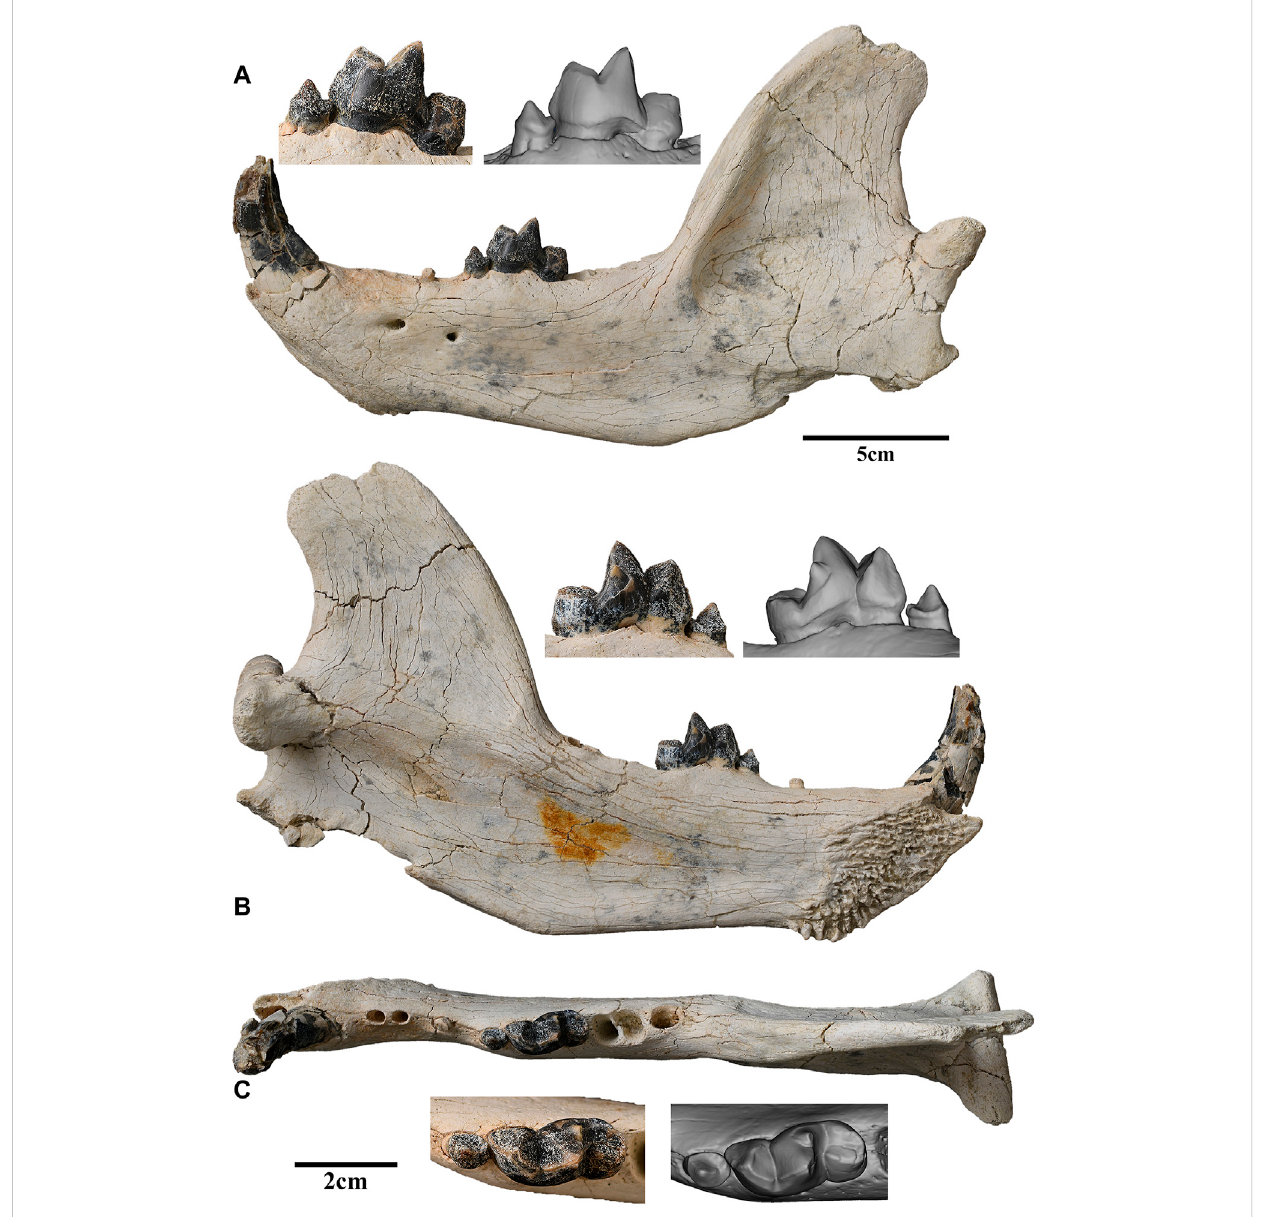
Leftlowerjaw of Lonchocyonqiui gen. etsp.nov.with c,p4,andm1(IVPP V28616): (A) lateralview; (B) lingual view; and (C) occlusalview.Scale bar equals 5 cm for the lower jaw and 2 cm for the